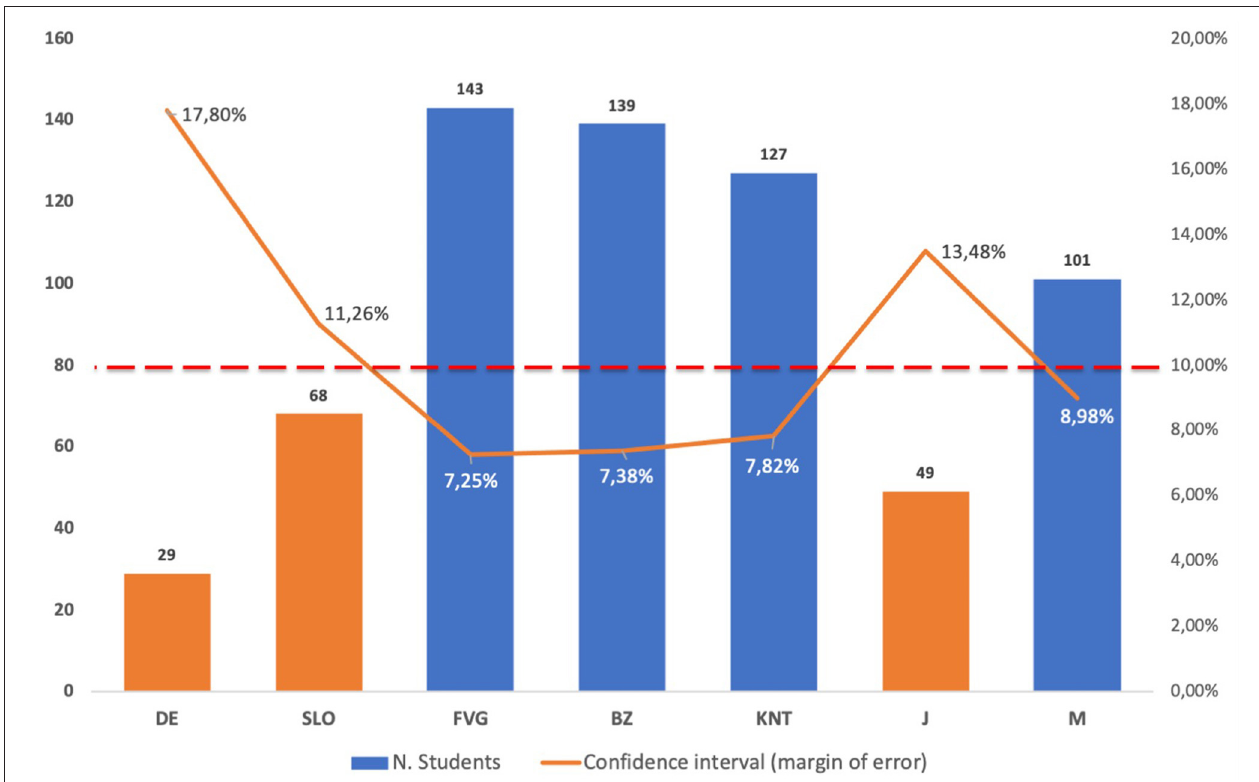
FIGURE 3 | Regions or countries that participated to the research, number of students, and confidence interval (margin of error) of the survey with a confidence level of 95%: DE = Germany ( n = 29–17.80%), SLO = Slovenia ( n = 68–11.26%), FVG = Friuli Venezia Giulia Region Italy ( n = 143–7.25%), BZ = Autonomous Province of Bolzano Italy ( n = 139–7.38%), KNT = Carinthia, Austria (127–7.82%), J = Japan ( n = 49–13.48%), M = Mauritius ( n = 101–8.98%). The confidence level threshold below which the sample was considered not statistically representative is 10%. The sample size with a confidence level of 95% and a confidence interval of 10% with unlimited population size is 97 subjects for each